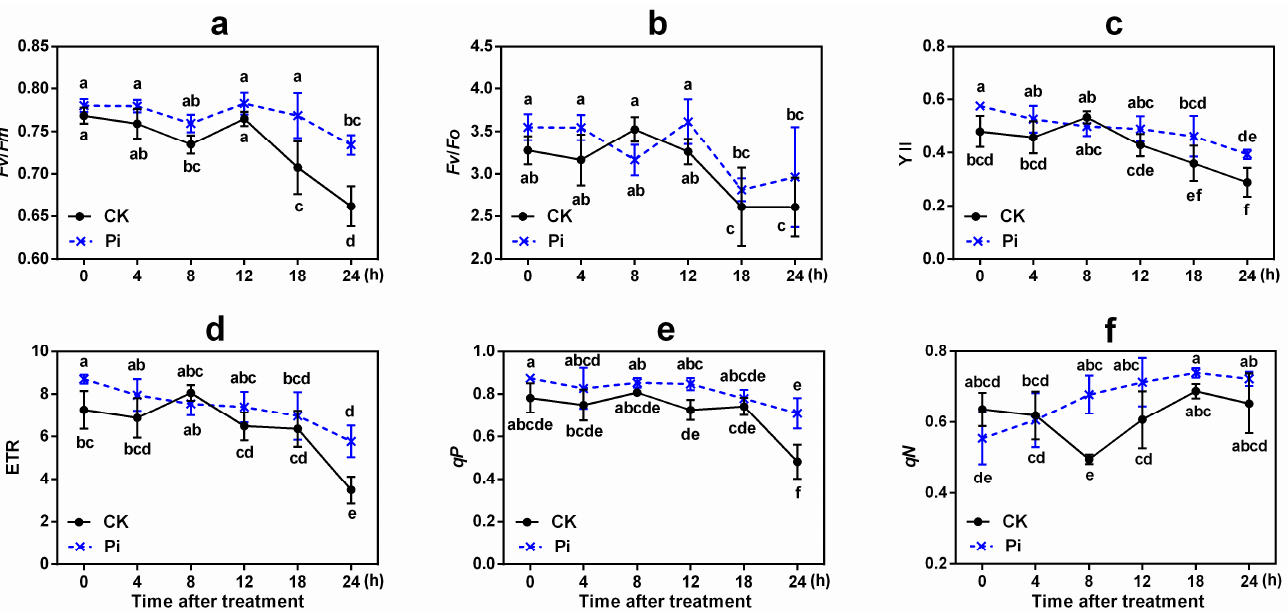
Figure 3. Effects of P. indica on chlorophyll fluorescence parameter changes in banana leaves under cold stress treatment. ( a ) F v / F m , maximum photochemistry efficiency of PS II; ( b ) F v / F o , potential photosynthetic efficiency of PS II; ( c ) Y(II), efficient quantum yield; ( d ) ETR, photosynthetic electron transport rate; ( e ) qP , photochemical quenching coefficient; and ( f ) qN , non-photochemical quenching coefficient. Different letters above the bars indicate a significant difference ( p < 0.05) from CK (0 h) between the CK and Pi groups. Error bars represent SDs ( n = 3).